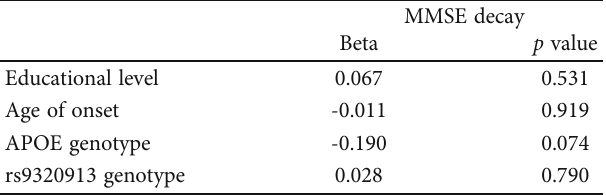
Slope: ANOVA analysis F value = 1 : 055 ( p value